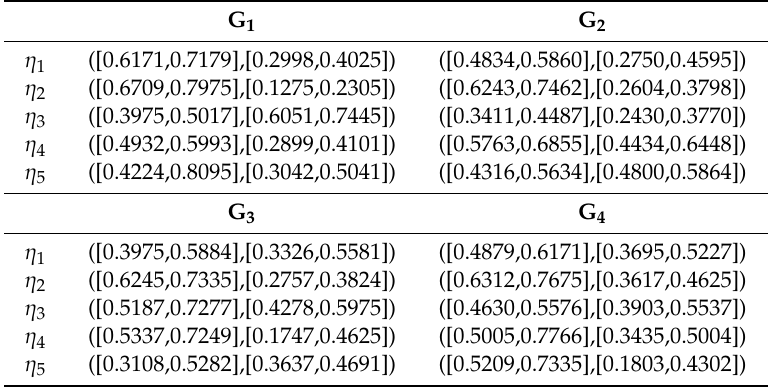
Table 5. The fused q-RIVOFNs matrix.